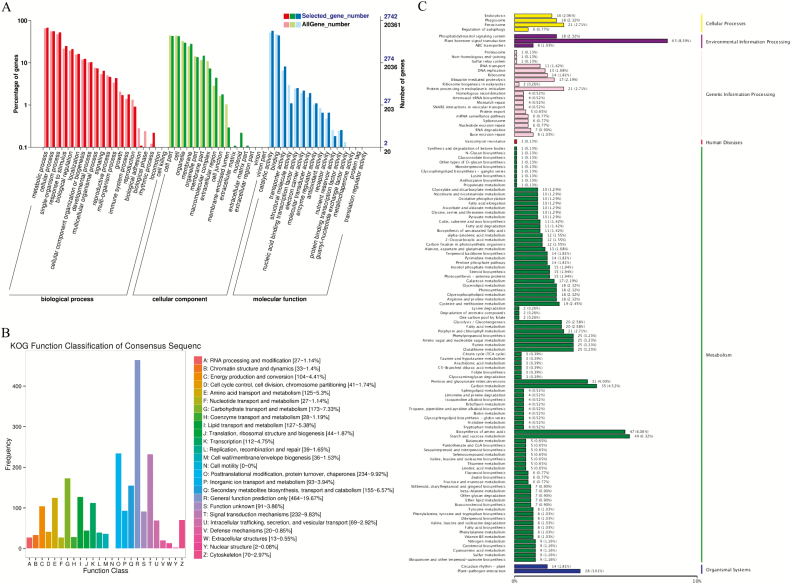
GO, KOG, KEGG enrichment of DEGs. (A) GO enrichment of DEGs; (B) KOG enrichment of DEGs; (C) KEGG enrichment of DEGs.